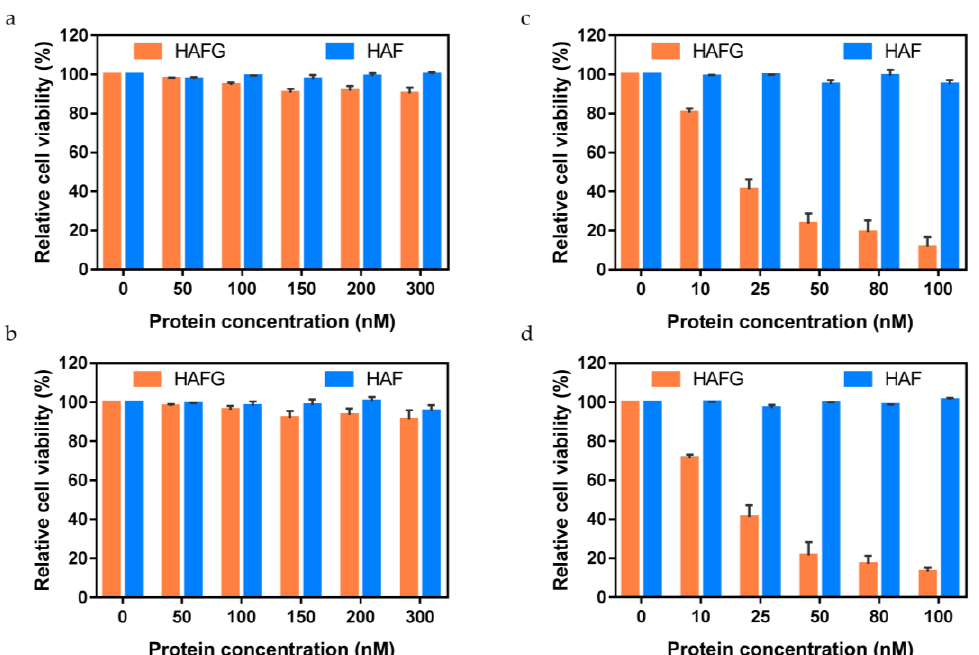
Figure 6. CCK-8 assay results to estimate the therapeutic effect of HAFG. ( a ) CCK-8 assay result of EGFR-overexpressing HT-29 cells. The cell viability was constant regardless of the concentration of HAF or HAFG. ( b ) CCK-8 assay result of EGFR-overexpressing A431 cells. The cell viability was constant regardless of the concentration of HAF or HAFG. ( c ) CCK-8 assay result of EGFR-overexpressing HT-29 cells under AMF. The cell viability decreased remarkably in proportion to the concentration of HAFG. ( d ) CCK-8 assay result of EGFR-overexpressing A431 cells under AMF. The cell viability decreased remarkably in proportion to the concentration of HAFG. In this figure, mean and standard deviation are presented ( n = 6). The viability measured without protein was presented as 100% for each